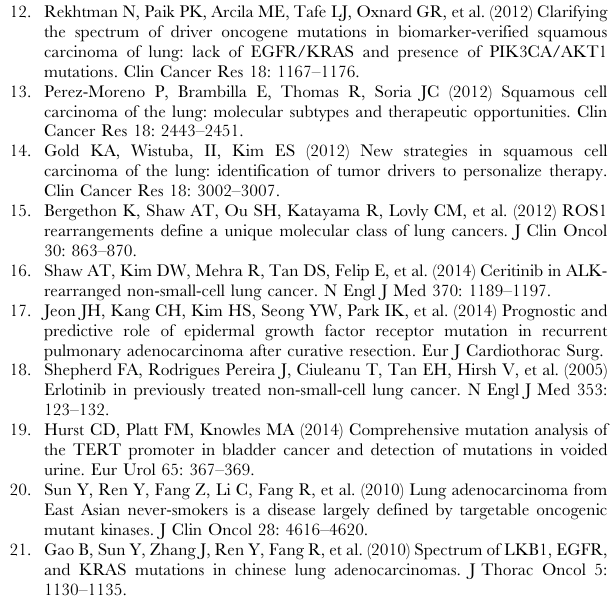
Table S1 List of primers used for polymerase chain reaction amplification of the EGFR, KRAS, HER2 and BRAF gene. Table S2 Mutational and survival information of 174 NSCLC patients. Sex, 1 male, 2 female; Smoking, 0 non-smoker, 1 smoker; path, pathology; WT, wild-type; DEL, deletion; INS, insertion; NEG, negative; POS,